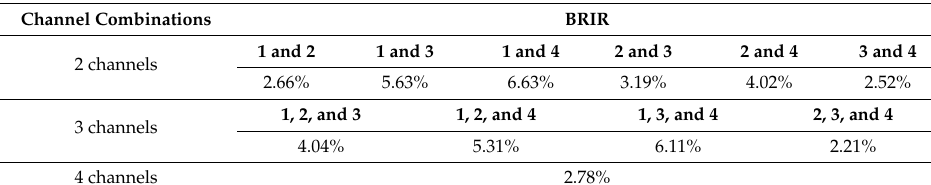
Table 3. BRIR for data fusion results with different channel combination of the multistatic UWB radar. The data was measured when the volunteer was (6 m, 0 ◦ ) away from the radar.